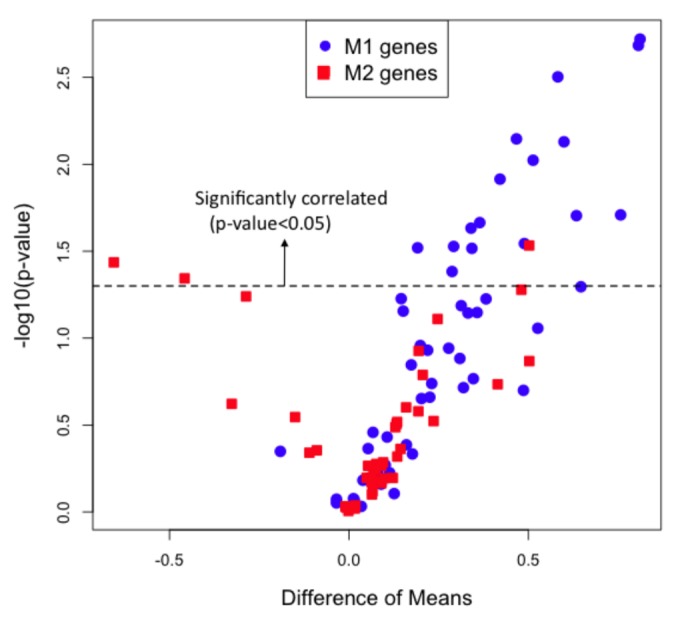
Differential expression of M1- and M2-related genes.Volcano plot of M1- and M2-related probe sets differentially expressed between patients with high PCNA+ TAMs and low PCNA+ TAMs. The x-axis corresponds to the difference of the mean expression values for a given probe (high PCNA+TAMs minus low PCNA+ TAMs), and the y-axis corresponds to the p value (Student’s t test). The horizontal dashed line indicates the p=0.05 cutpoint for significance. These results were not corrected for multiple testing.